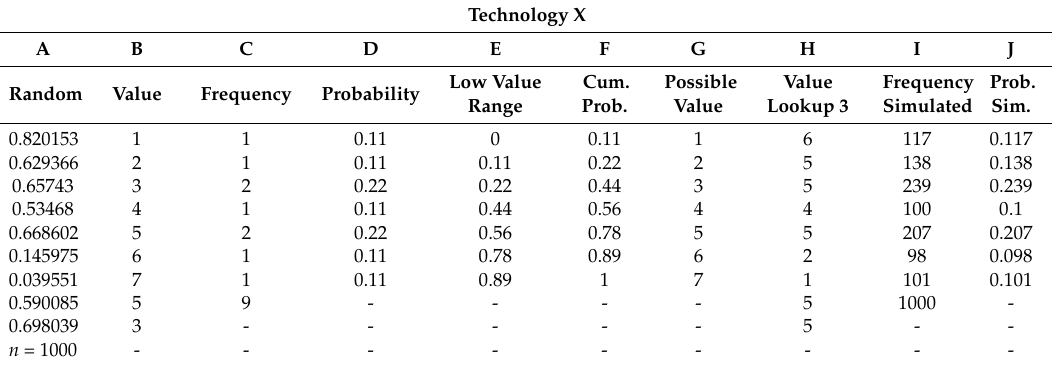
Table 9. Illustrative example for the explanation of the Monte-Carlo validation technique. Technology